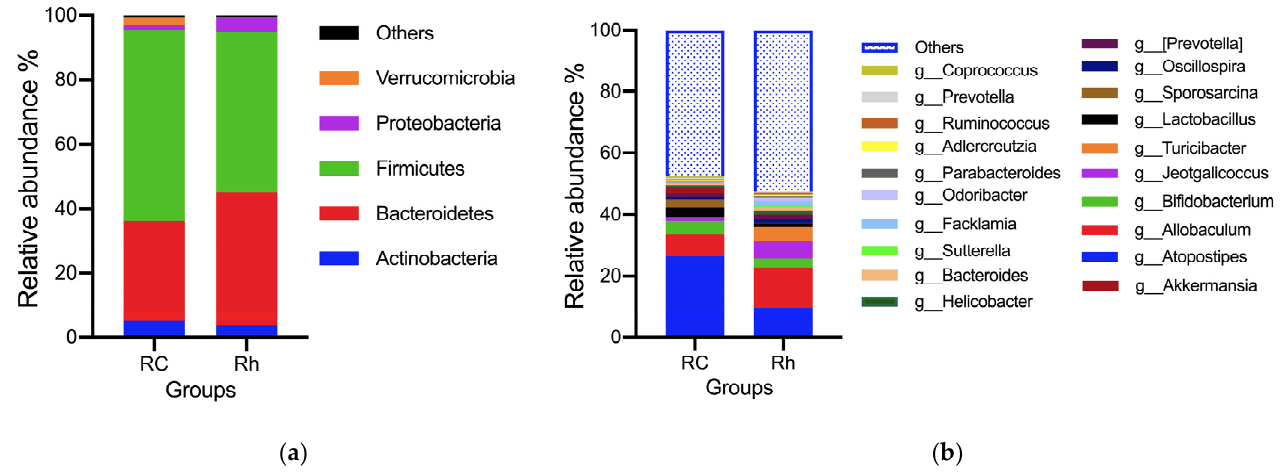
Figure 7. Comparison of the gut microbiota by the relative abundances at the phylum ( a ) and genus level ( b ).